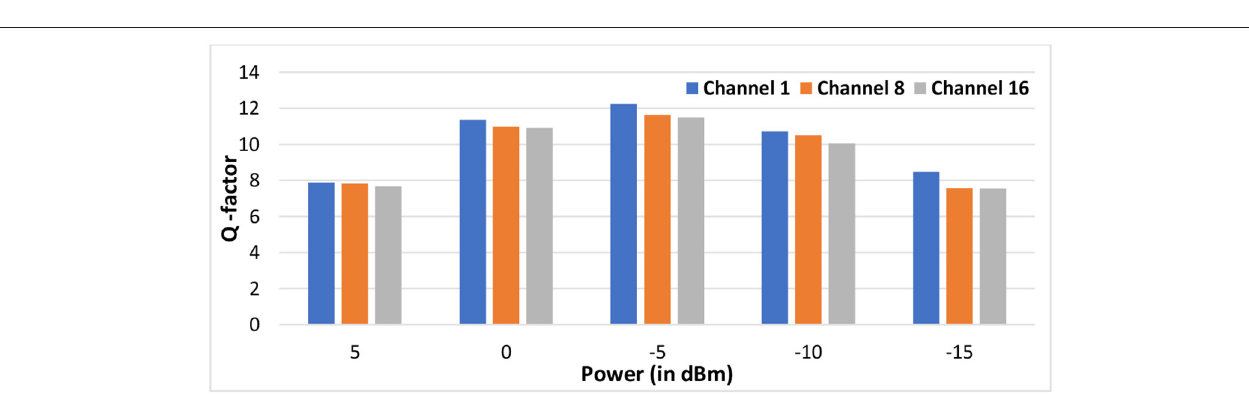
FIGURE 12 | Variation of Q factor with power at channel spacing of 100